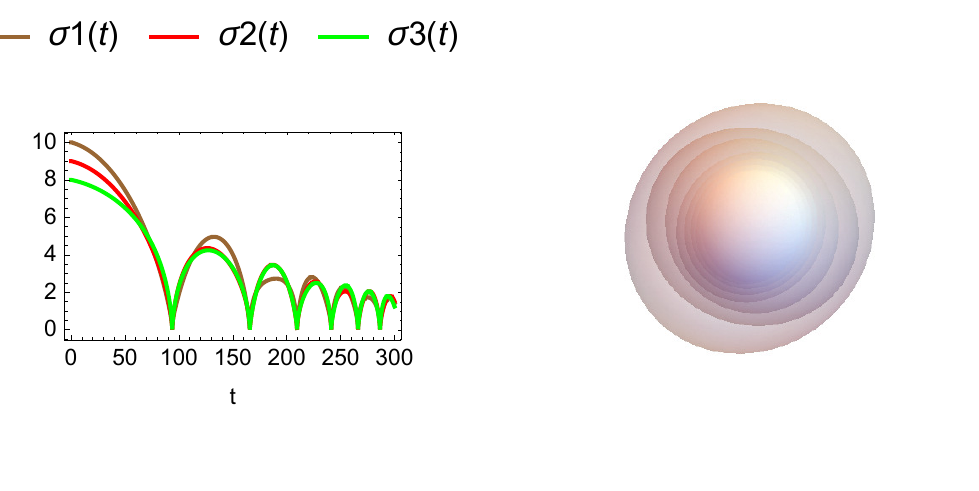
Figure 2. Time evolution of a dissipative anisotropic BEC collapse. ( Left ) A damping collapse of BEC. This is a typical solution derived from the effective Lagrangian Equation (14). ( Right ) The superposition of the snapshots of BEC field at each maximum expansion. It forms the concentric almost spherical shells around the formed